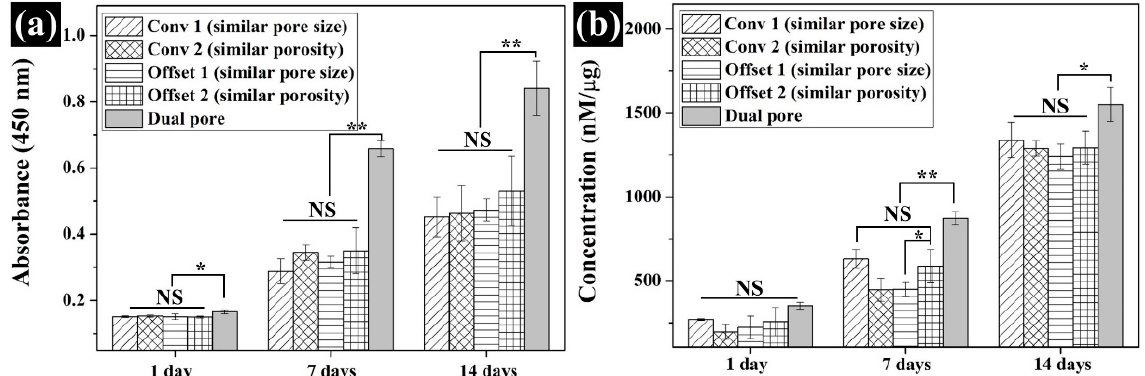
Figure 7. Comparison of the in vitro cell response of the scaffolds: ( a ) CCK-8; ( b ) ALP (NS: nonsignificant, * p < 0.05, ** p < 0.01).